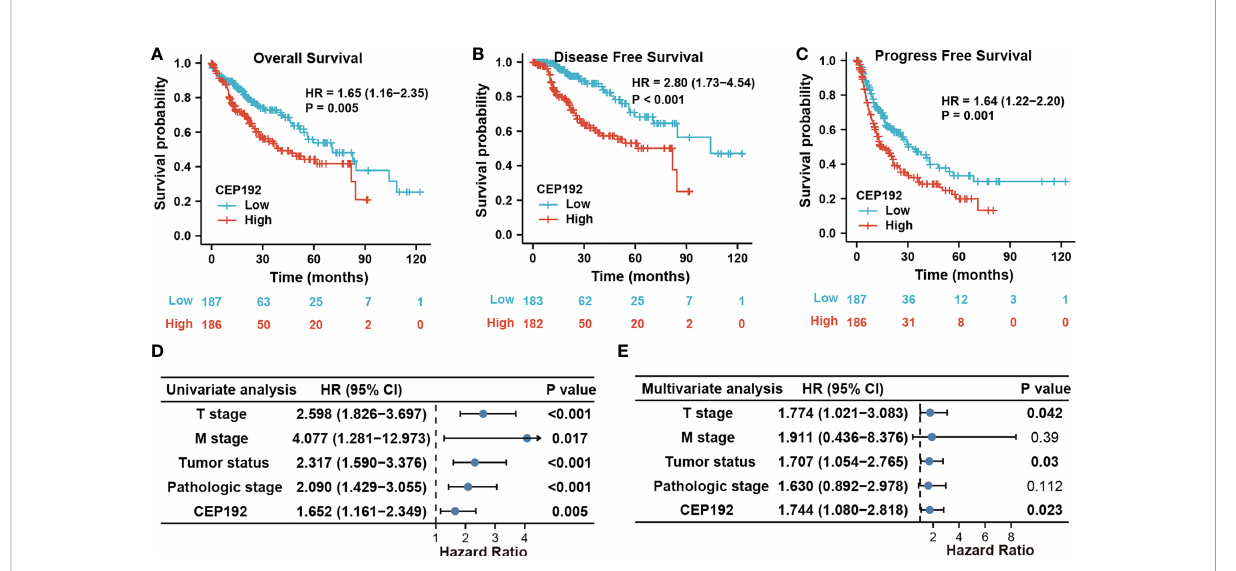
FIGURE 3 CEP192 expression was correlated with poor survival outcomes in HCC patients. (A – C) Kaplan – Meier analysis for overall survival (A) , disease- free survival (B) , and progression-free survival (C) based on high versus low CEP192 expression in TCGA-LIHC samples; Log-rank (Mantel-Cox) test. (D) Forest plot showing the univariable Cox model results of T stage, M stage, tumor status, pathologic stage, and CEP192 expression in HCC; Cox proportional hazards regression. (E) Forest plot showing the multivariable Cox model results of the fi ve risk factors in (D) ; Cox proportional hazards